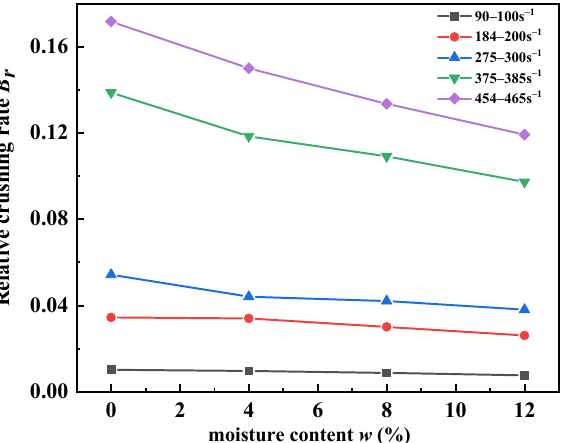
Figure 14. Relative crushing rate of dry sand specimens with initial relative density of 0.9 for dif- ferent strain rates.